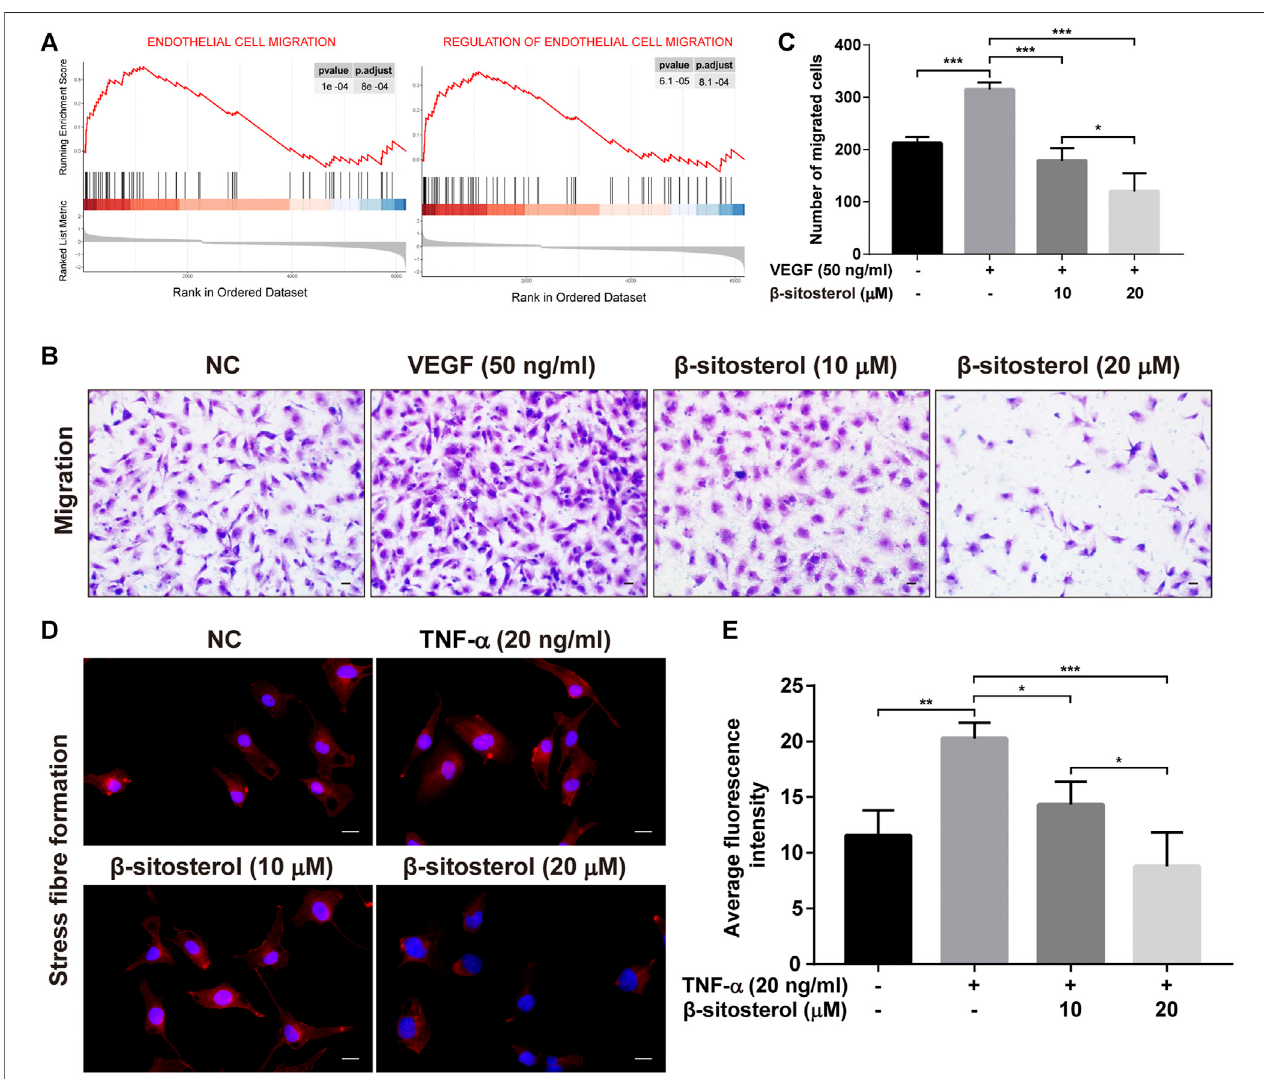
FIGURE 3 | Inhibitory effect of BSS on HUVECs migration induced by VEGF or TNF- α . (A) GSEA analysis of ECs migration in GSE121894 dataset. (B) Representative imagesof cell migration in a modi fi ed Boyden chamber following HUVECs induced by VEGF stimulation (×200, scale bar = 50 μ m). (C) Y -axis shows the number of migrated cells ( n = 3). (D) Representative images of stress fi ber formation on TNF- α stimulation (20 ng/ml for 24 h) (×630, scale bar = 20 μ m), Nuclei are stained with DAPI (blue). (E) Y -axis shows fl uorescence intensity quanti fi ed by ImageJ ( n = 3). All data are shown as the mean ± SEM. * p < 0.05, ** p < 0.01, *** p <